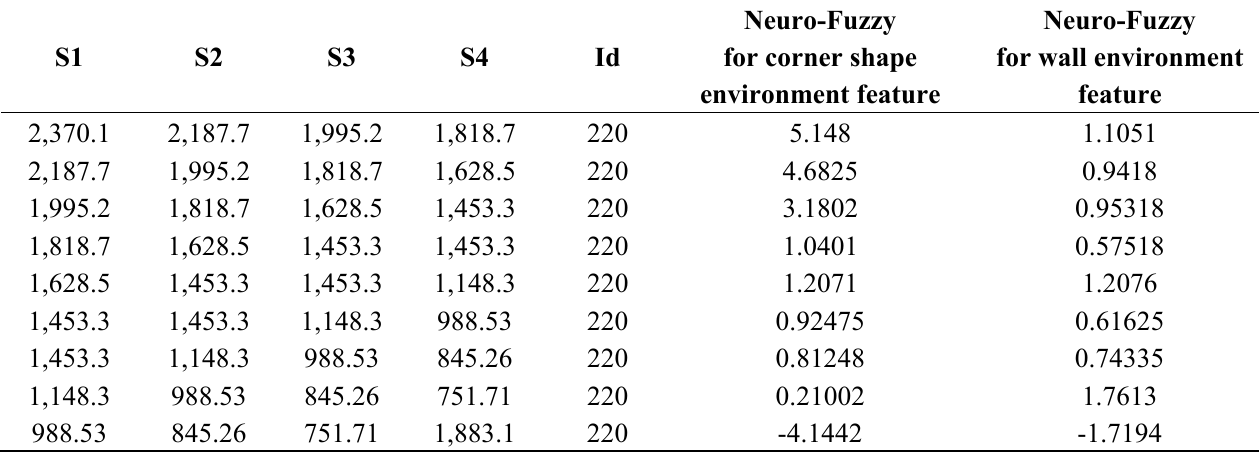
Table 7. Outputs of the Neuro-Fuzzy systems for real data when the vehicle is passing the entrance of a building as it is seen in Figure